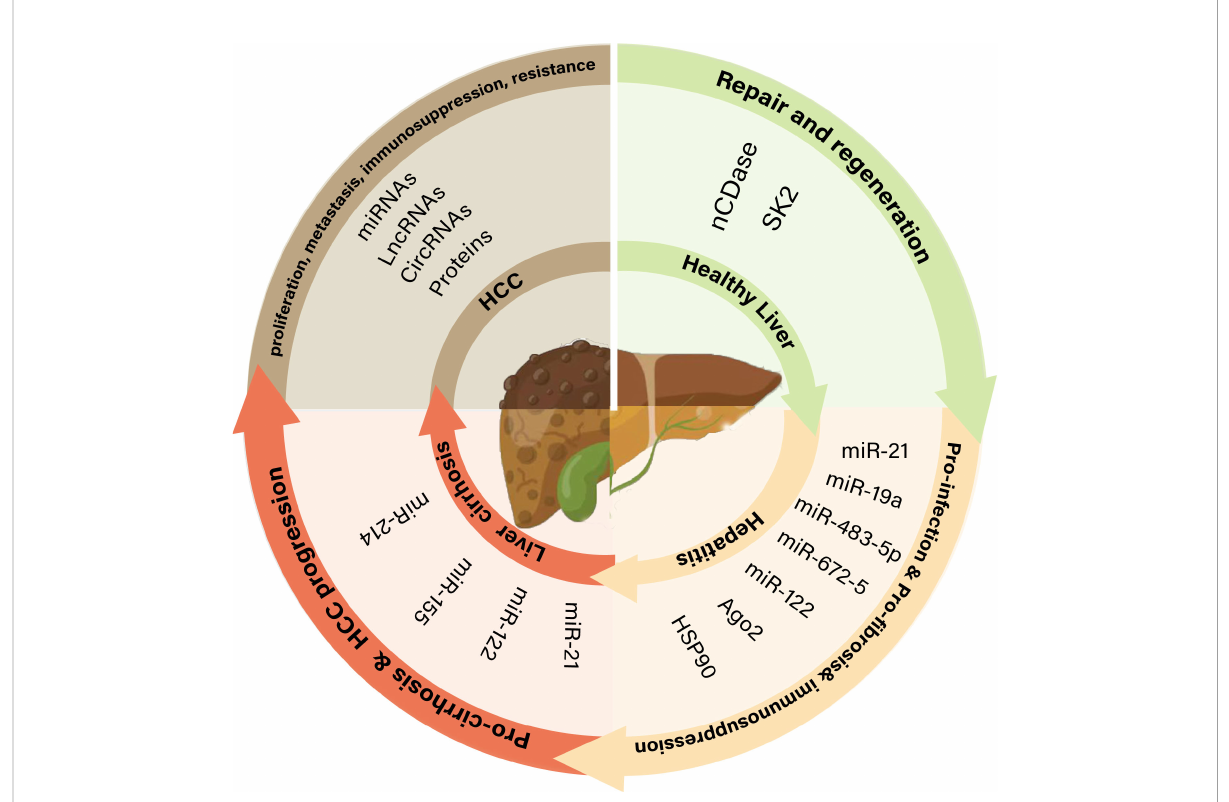
FIGURE 1 The role of exosomes in different pathophysiological states of the liver. nCDase, neutral ceramidase; SK2, sphingosine kinase 2; Ago2, argonaute-2; Hsp90, heat shock protein 90; lncRNAs, long non-coding RNAs; miRNAs, MicroRNAs; circRNAs, Circular